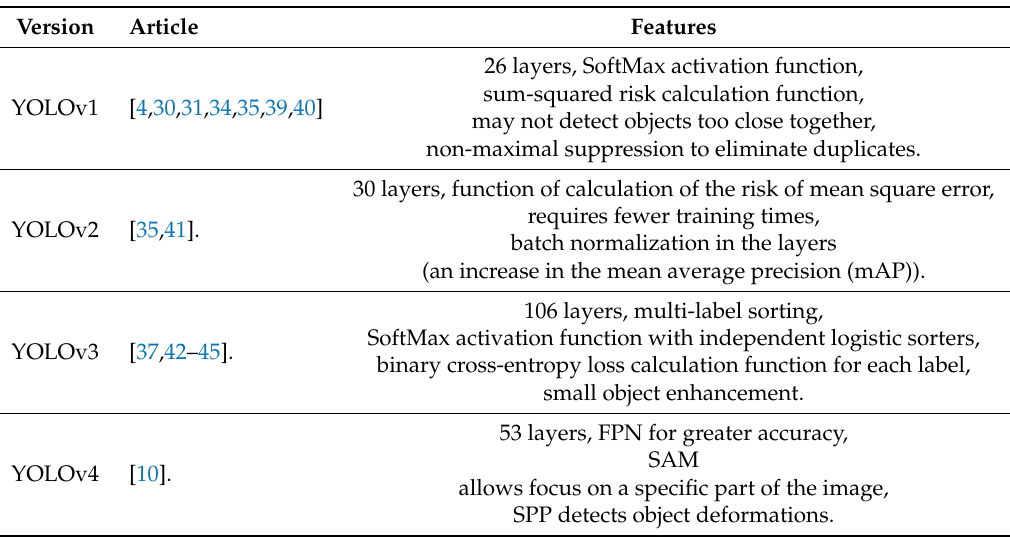
Table 1. You Only Look Once (YOLO) versions.